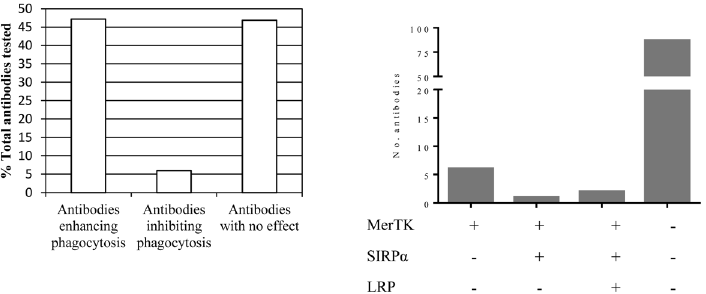
Fig 8. The majority of antibodies enhance apoptotic cell phagocytosis through recognition of unidentified surface molecules. Antibodies having a PI (cid:1) average PI + 1 SD (standard deviations) for cultures with no antibody treatment are considered as enhancing. Those having a PI (cid:3) average PI — 1 SD are considered inhibitory. All other antibodies having PI within 1 SD of average calculated for untreated M Φ ’ s are considered as having no effect. Frequency of each category of antibody is calculated as percent of total number of antibodies in the panel (left). Binding to known molecules could be detected in a small number of clones (right). Antibodies were evaluated by ELISA and readings that were (cid:1) 5-fold over background were considered